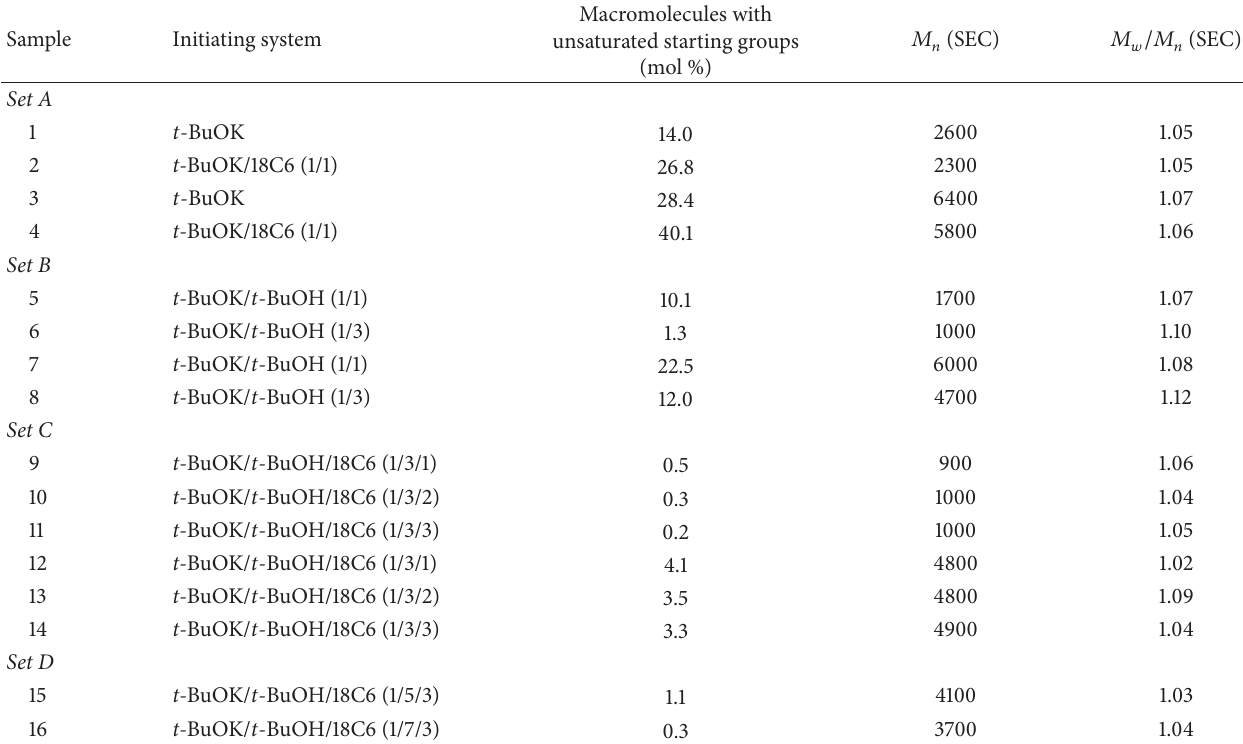
Table 1: Characterization of unsaturation of PPOs synthesized in the presence of t -BuOK including 18C6 or t -BuOH or t -BuOH/18C6 as